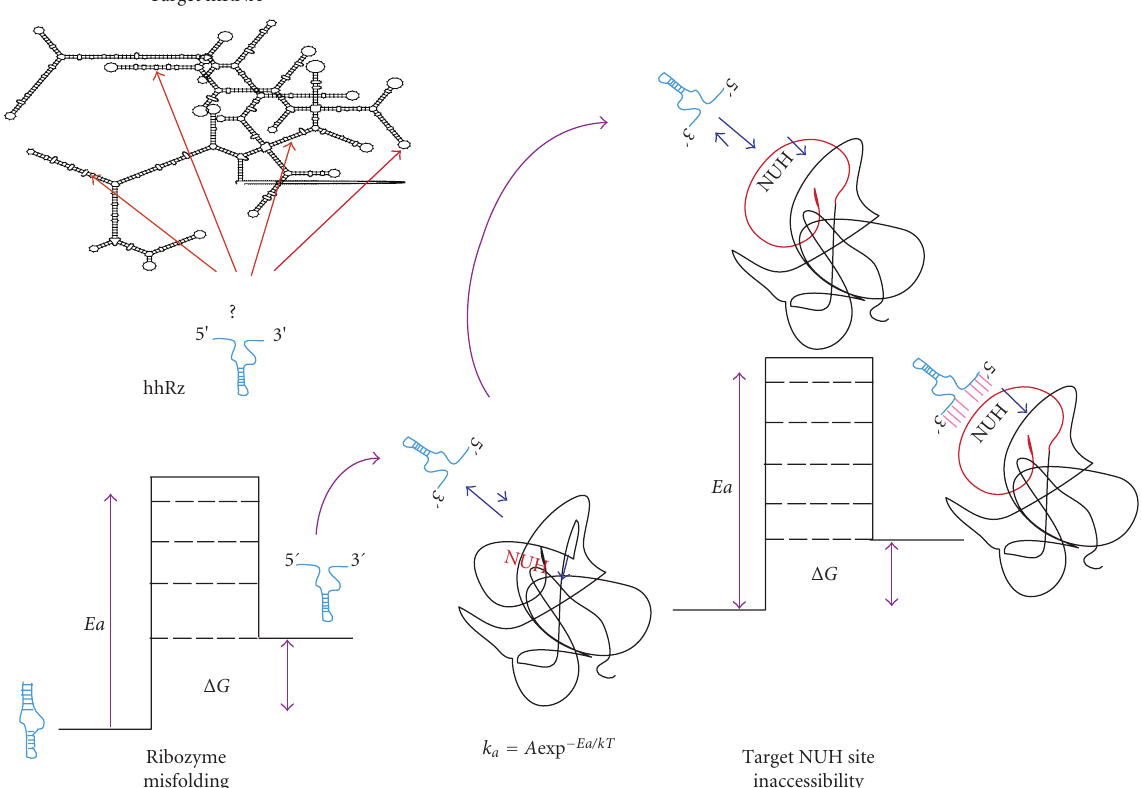
Figure 4: Secondary and tertiary structure as a limiting variable in PTGS e ffi cacy. Energy diagrams are presented for both the target mRNA and the PTGS agent. The folded target mRNA has a site targeted for annealing which is buried in secondary or tertiary structure. The rate of unfolding of this region is determined by the activation energy required for conformational transition that leads to accessibility of the annealing platform. For the folded target RNA to be accessible it must present a single-stranded annealing platform(s) at its surface to allow annealing with the PTGS agent upon intermolecular collision. Buried regions of the RNA that are targeted must wait at physiological temperatures for relaxation of secondary and tertiary structure in order to present an annealing platform. Many regions are expected to never be exposed. The Arrhenius rate provides an estimate of how long it takes for a single-stranded platform to emerge at physiological temperature (310 ◦ K = 37 ◦ C) and is dependent upon the activation energy ( Ea ) of the transition. Likewise, any internal secondary structure of the PTGS agent itself can prevent annealing to target or slow catalysis and impact e ffi cacy. Melting of inhibitory secondary or tertiary structure in the PTGS agent then can allow exposure of the antisense flanks to support annealing to the target